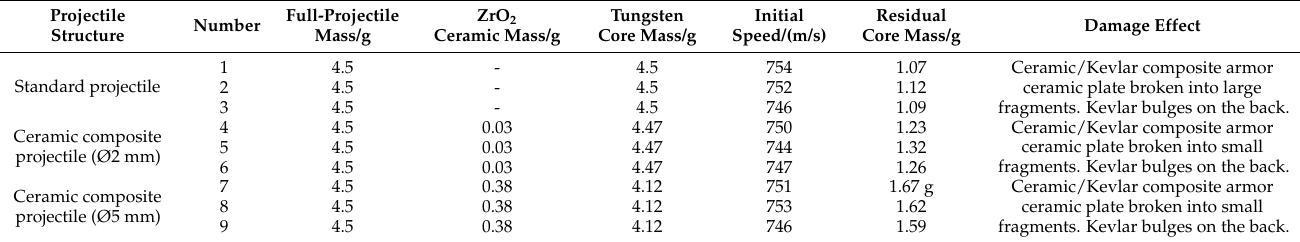
Table 4. Test results of projectile cores penetrating the ceramic/Kevlar composite armor in different structures.